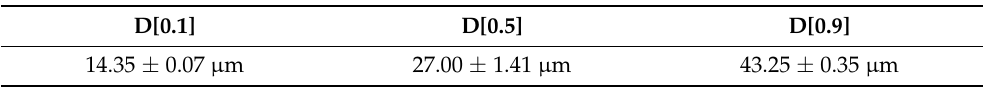
Figure 6. Images of one random mapped area of Bismuth Oxide 120 mg FC Tabs after dispersion in original mode ( A ) and after image analysis method ( B ) using 50 × magnification objective lens. Table 2. Average cumulative PSD values of bismuth oxide API particles in 120 mg FC Tabs after disintegration of the tablet.